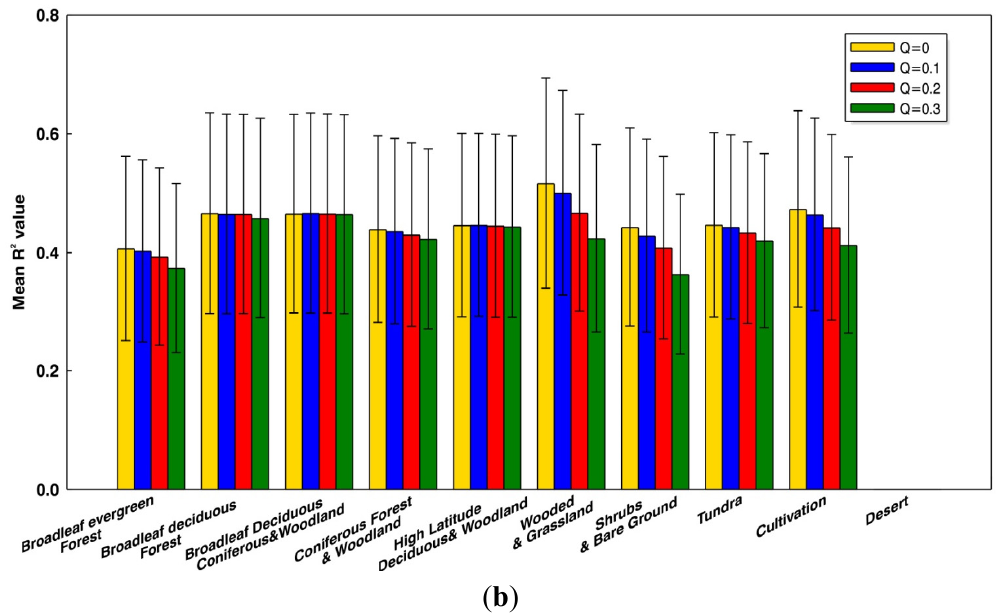
Figure 8. ( a ) Sensitivity analysis: influence of the Q parameter (for (cid:1843) =0, (cid:1843) = 0.1, (cid:1843) = 0.2 and (cid:1843) = 0.3) on the mean values of Hr for a variety of biomes; ( b ) Sensitivity analysis: influence of the (cid:1843) parameter (for (cid:1843) =0, (cid:1843) = 0.1, (cid:1843) = 0.2 and (cid:1843) = 0.3) on the mean (cid:1844) (cid:2870) values of the regression Equation (11) for a variety of biomes.